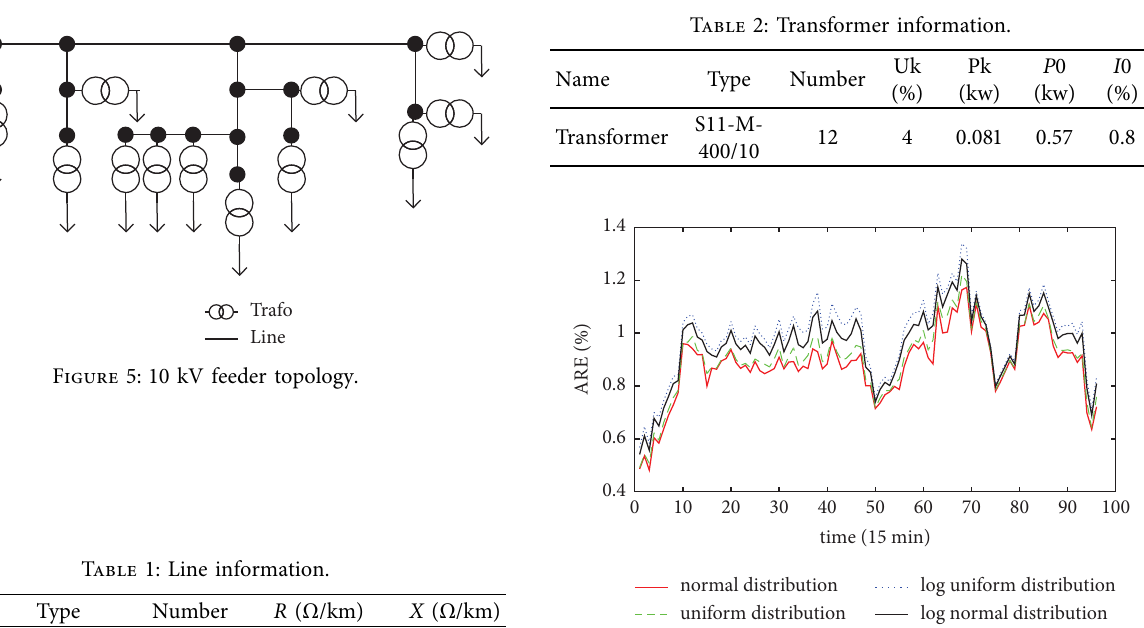
Figure 6: ARE of voltage under diferent